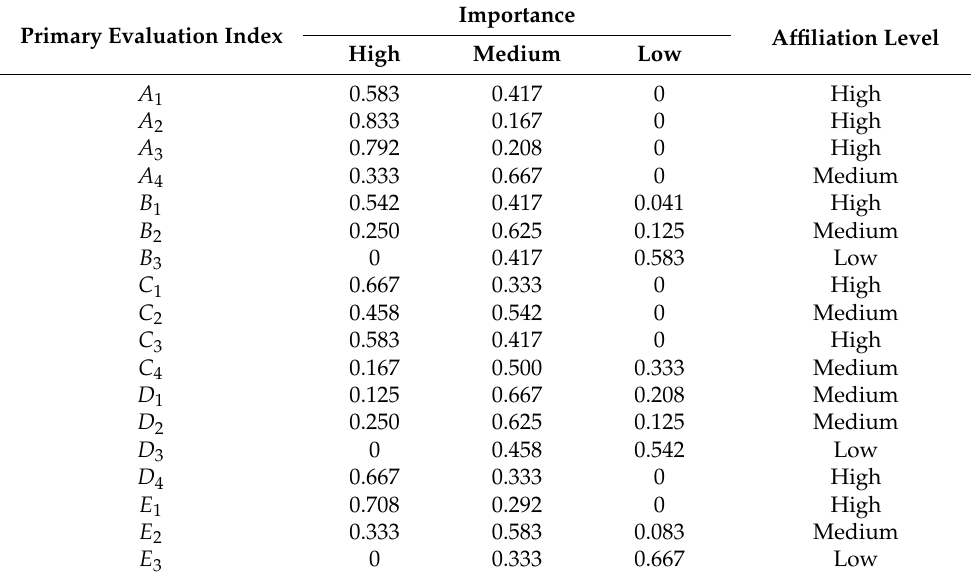
Table 4. Gray statistical weight vectors of evaluation indicators in the gray